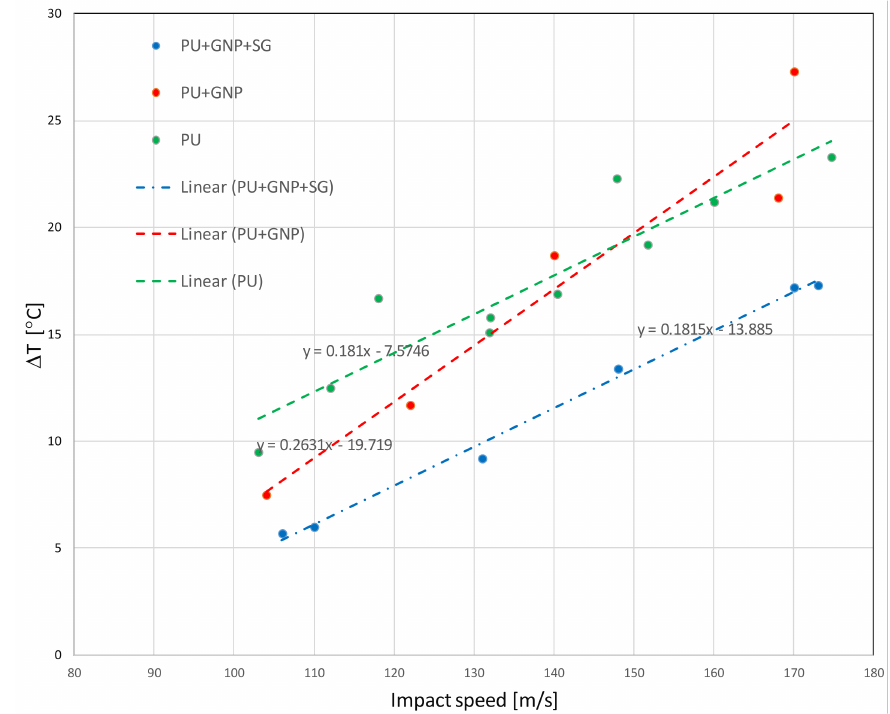
Figure 13. Peak ∆ T Impact heating as a function of impact speed for the three different